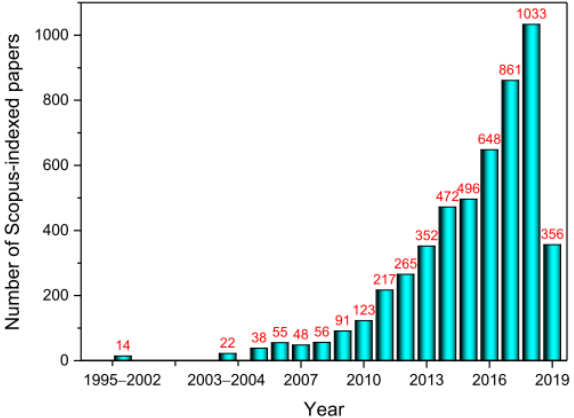
Figure 1. Time distribution of papers dealing with energy-related applications of electrospun nanomaterials (ENMs) published in Scopus-indexed scientific journals from 1995 to January 2019.